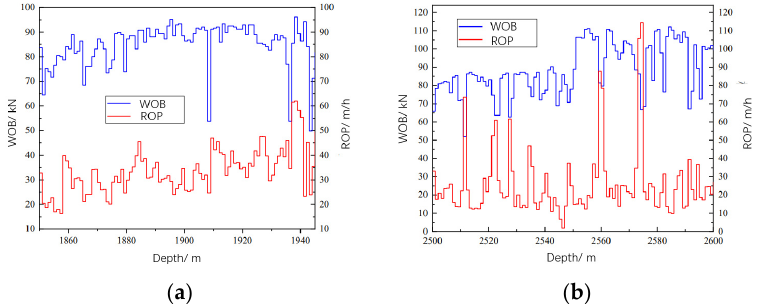
Figure 4. The relationship between WOB and ROP: ( a ) well X-2 Upper formation and ( b ) well X-2 lower formation. lower